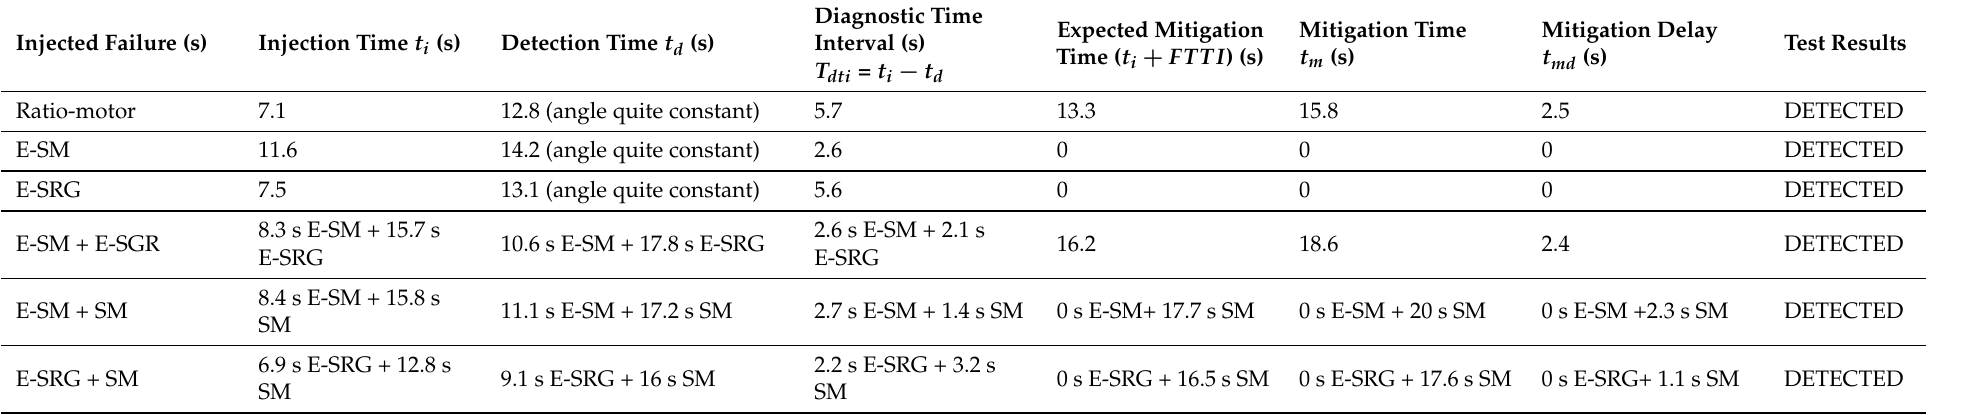
Table 7. Simulation results for the steering subsystem. Ratio-motor indicates a failure affecting SM or SGR since their positions are mechanically